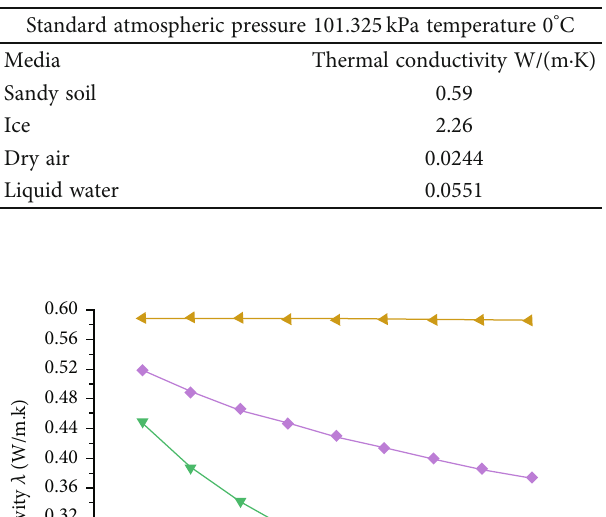
Table 2: Medium thermal conductivity.